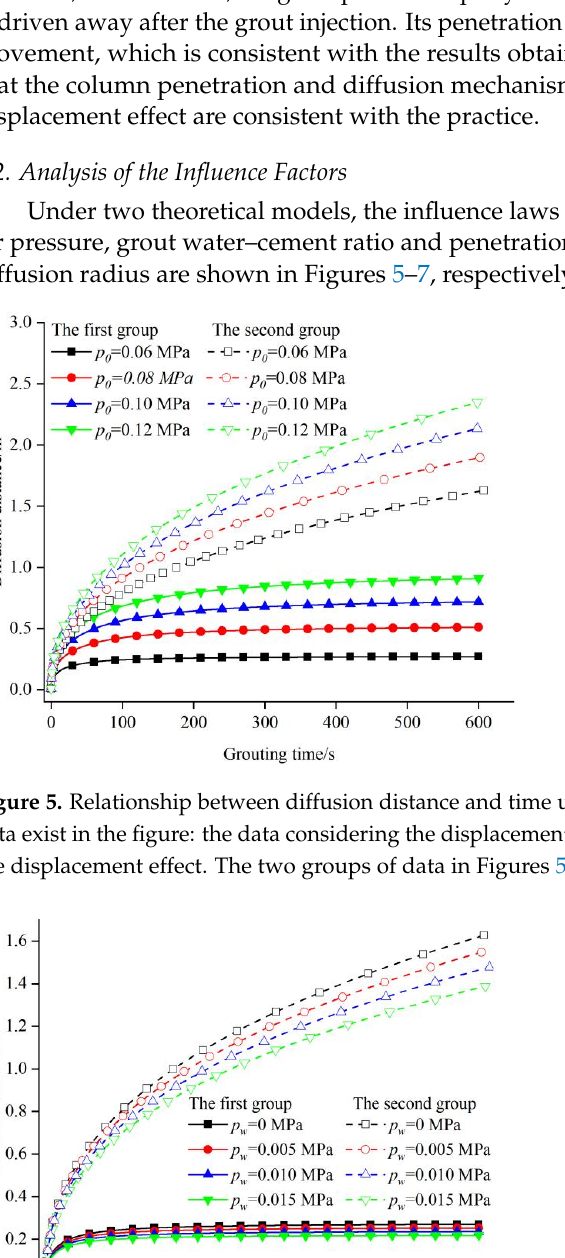
Figure 7. Influence of the water–cement ratio on the diffusion radius of Bingham cement grout.